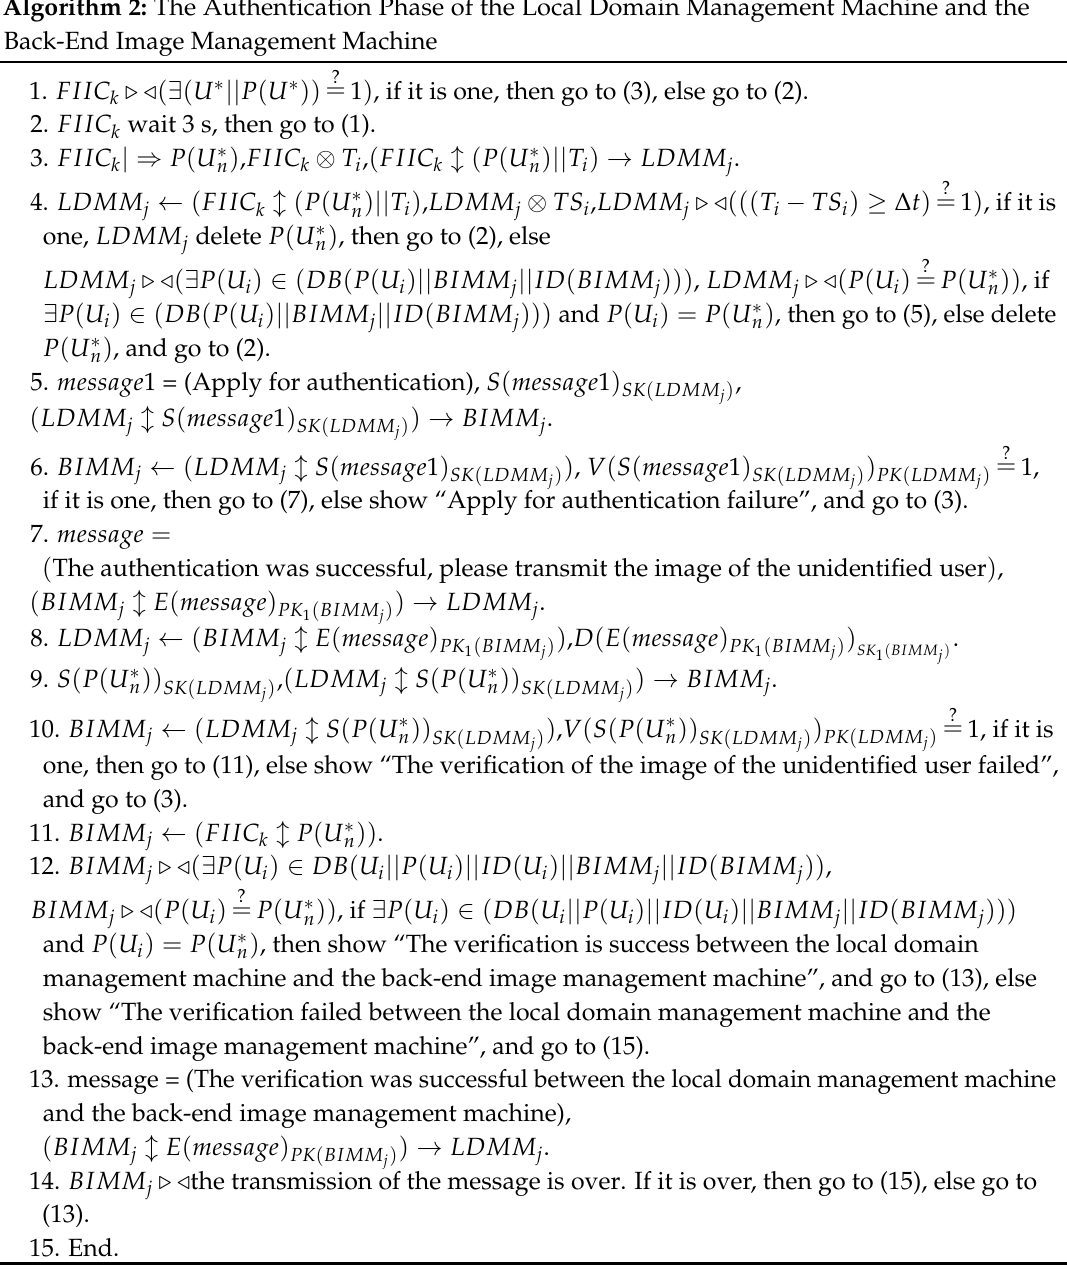
Algorithm 2: The Authentication Phase of the Local Domain Management Machine and the Back-End Image Management